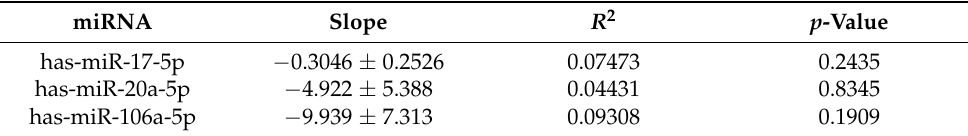
Table 3. Correlation analysis of miRNAs and the percentage of lipid reduction after atorvastatin treatment. miRNA